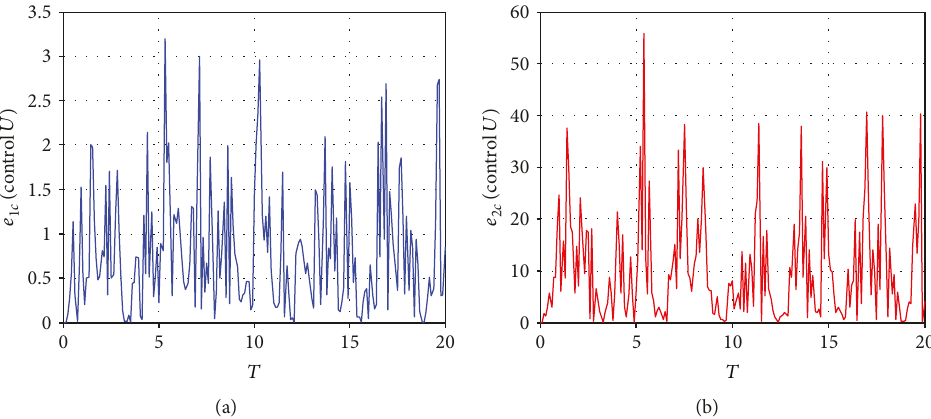
Figure 10: Deviation of the desired trajectory with the proposed control with parametric errors in feedback control and feedforward: (a) deviation of the desired trajectory e 1